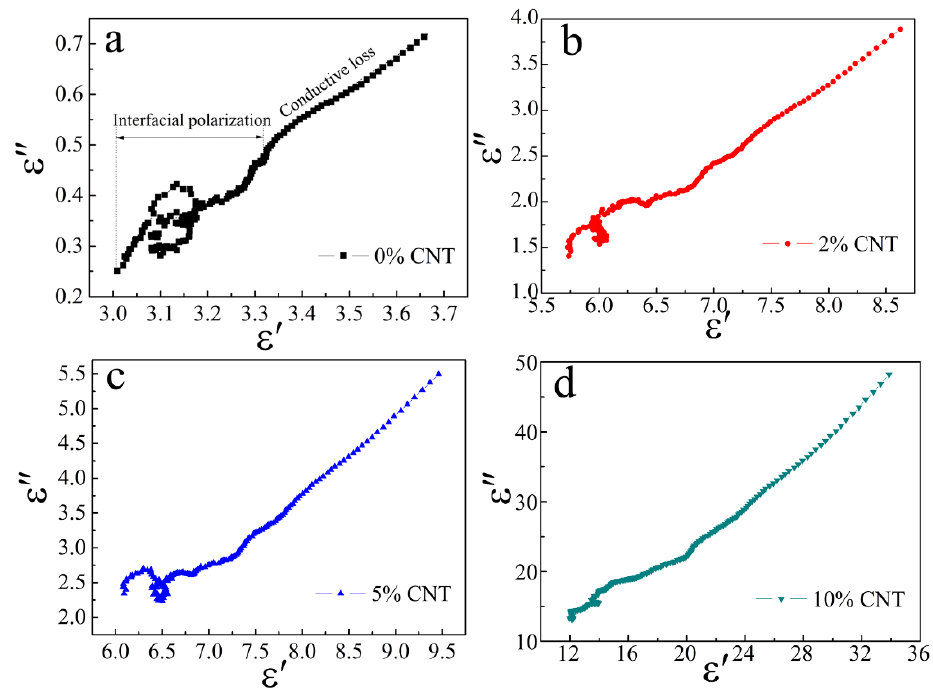
Figure 8. Plots of ε′−ε′′ for the composites. ( a ) 0% CNT, ( b ) 2% CNT, ( c ) 5% CNT, and ( d ) 10% CNT.